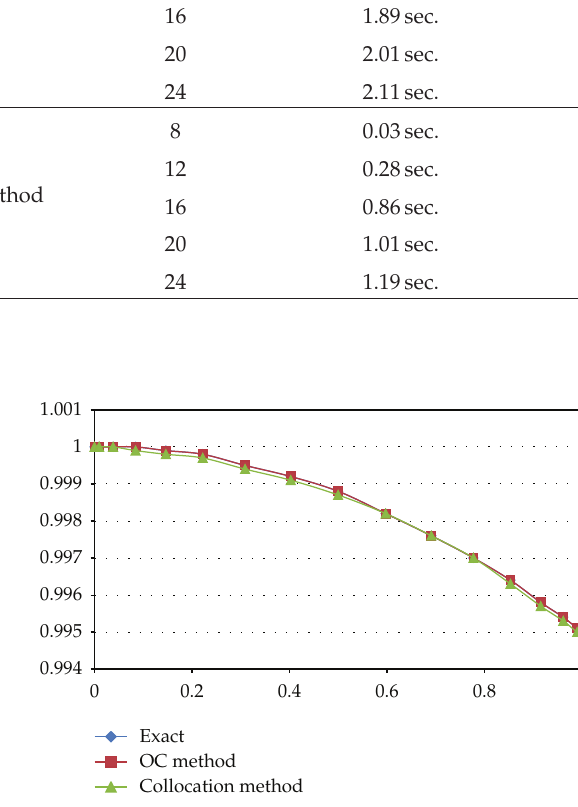
Figure 2: Observed results for Example 4.2 (cid:2) N (cid:7) 16 (cid:3)